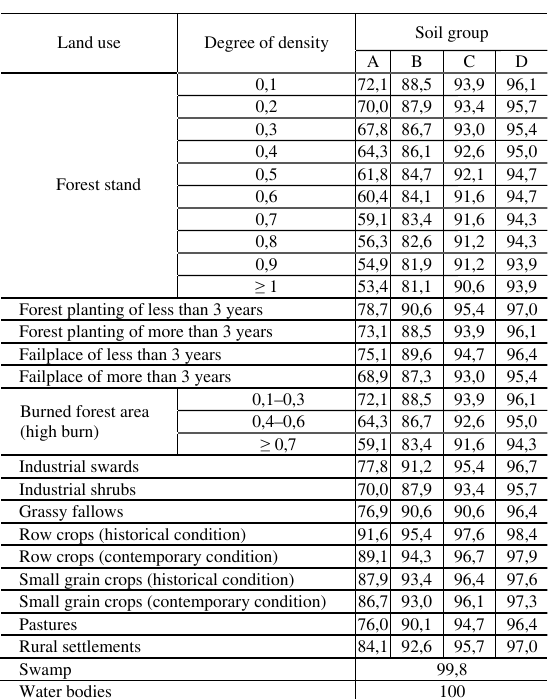
Table 2 . Empirical values of CN parameter according to modi- fied method for Trojanka catchment ( average mois- ture conditions